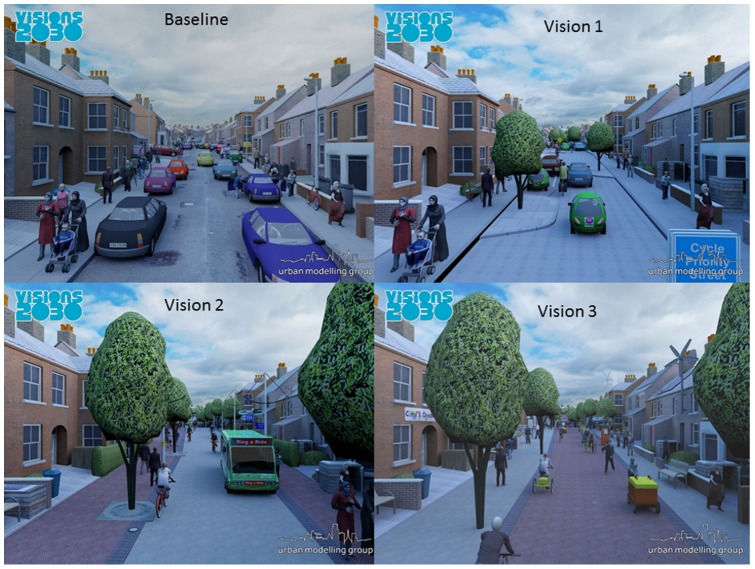
Visualisations for a typical urban terraced street.The four figures are taken from the visualisations used in the Visions 2030 Walking and Cycling Project http://www.visions2030.org.uk/. Each vision represents four different possibilities for urban transport in 2030 in the UK. These visualisations are of a ‘typical’ Victorian terraced street. Visualisations created by the School of Computing at the University of East Anglia.